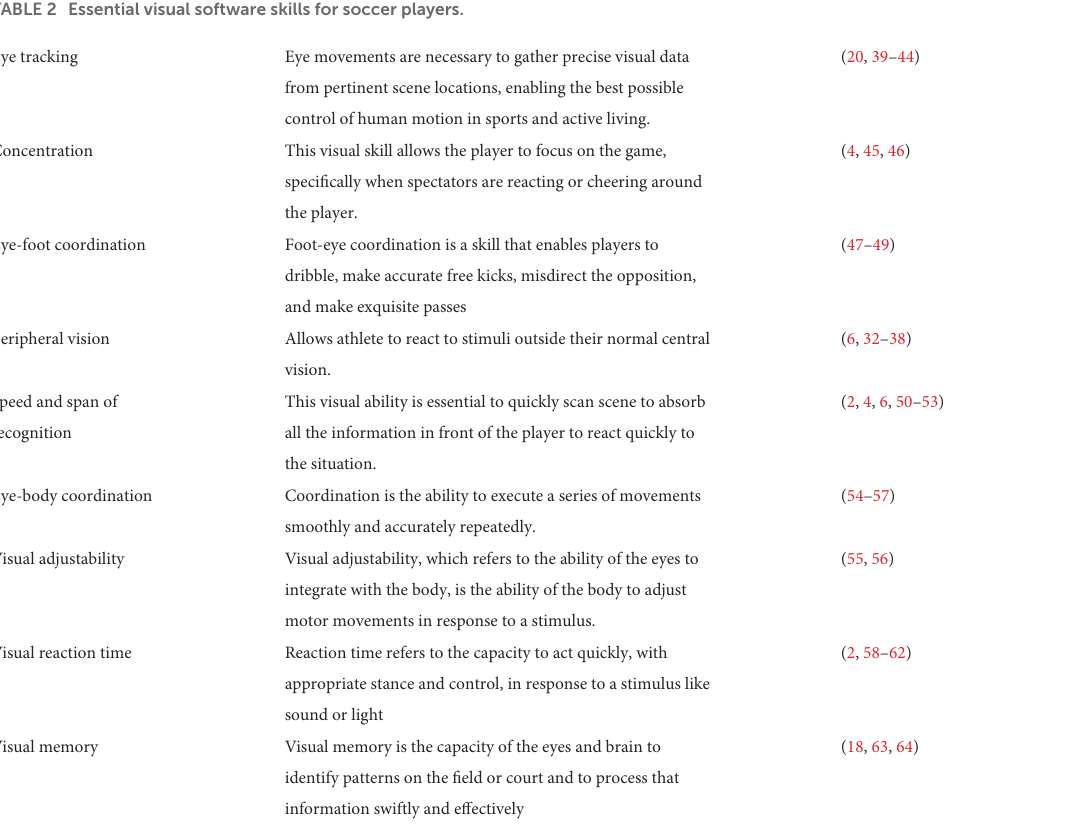
TABLE 2 Essential visual software skills for soccer